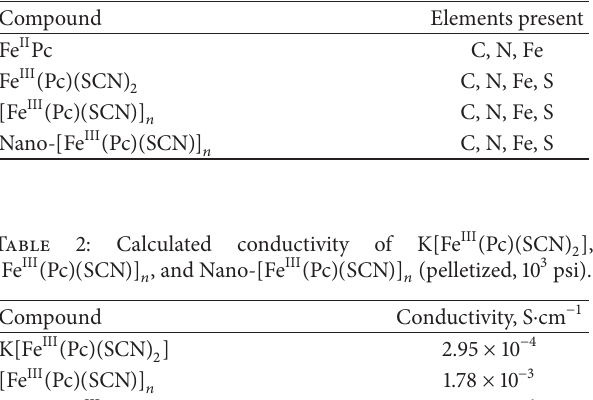
(Figure 6) of nanostructured [ Fe III ( Pc )( SCN )] 𝑛 revealed a broad and weak CN valence